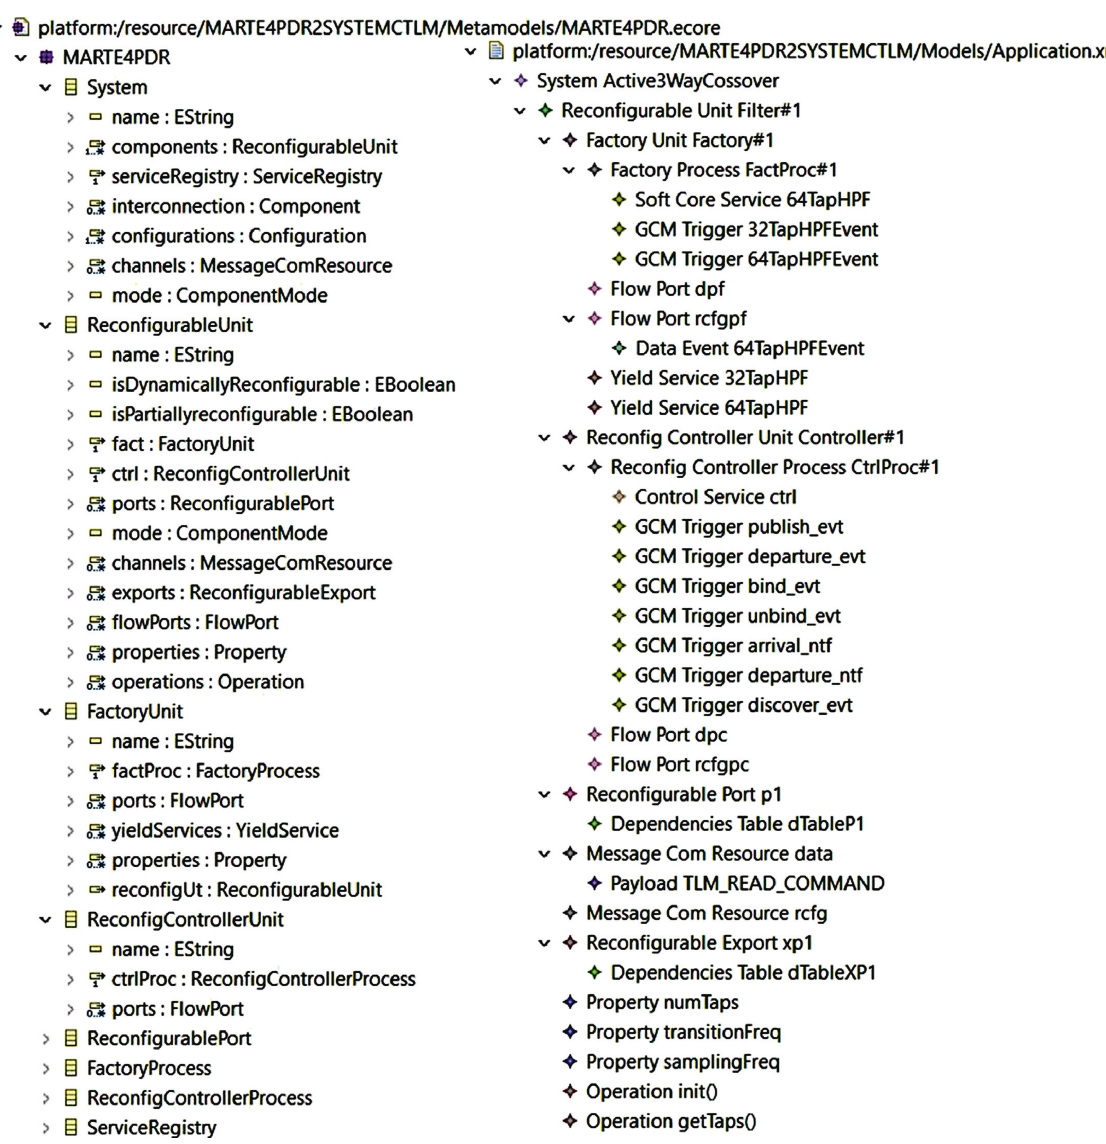
Figure 19: The MARTE4DPR metamodel (left) and the application model